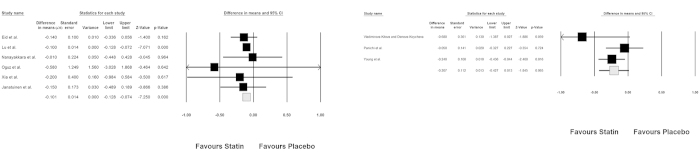
Forest plot detailing weighted mean difference and 95%Cl for the impact of hydrophilic (left) and hydrophobic (right) statins on plasma concentrations of ADMA. Meta-analysis was performed using a random-effect model with inverse variance weighting.